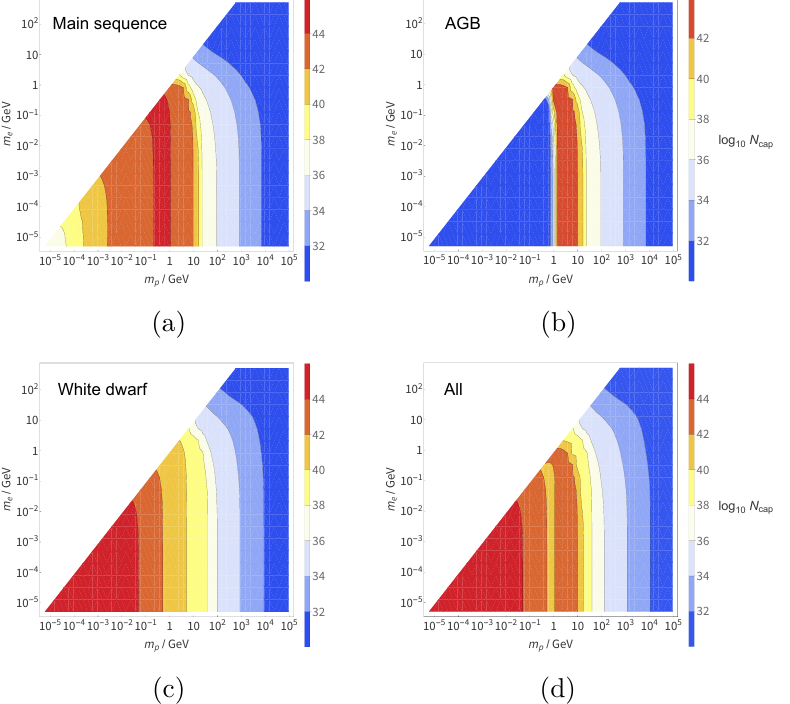
Figure 3 . aDM accumulation in our benchmark star (described in section 3.1) for (cid:15) = 10 − 11 , assuming ρ = 0 . 1 ρ and using the halo-like velocity assumption h v i = 220 km/s: (a) accu- aDM DM mulation at the end of the star’s main sequence lifetime, (b) accumulation at the end of the star’s AGB phase, shortly before it becomes a white dwarf. DM lighter than around 0.5 GeV is very efficiently evaporated away during the 100 million years the star spends burning helium. (c) DM accumulated during the star’s lifetime as a white dwarf only; (d) total accumulation, taking into account accumulation during the main sequence, AGB and white dwarf phases. Nugget density can be estimated from total accumulation for a given nugget temperature using the virial theorem, equation